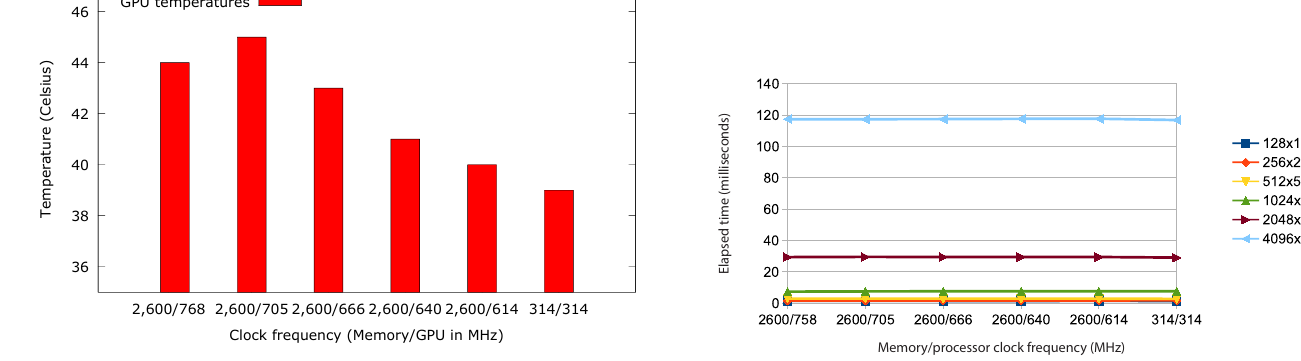
Figure 17. Temperature of GPU in cdpBezierTessellation benchmark.